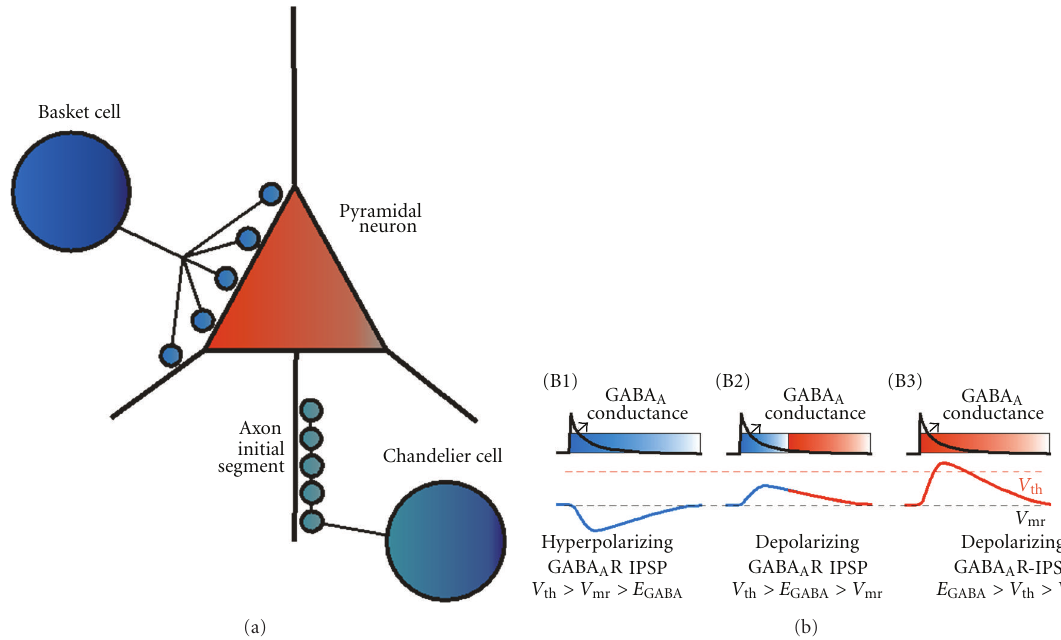
Figure 3: Diversity of perisomatic-targeting GABA neuron-mediated inhibition in cortical circuits may be due to di ff erences in the reversal potential for the GABA A -mediated current. (a) The scheme illustrates targeting by basket cells (either parvalbumin- or cholechystokinin- positive), which contact the soma and the proximal/perisomatic dendritic compartments, and by chandelier or axoaxonic neurons, which contact the axon initial segment. (b) The schemes illustrate di ff erences in the postsynaptic e ff ect of a GABA A R conductance according to the ) relative to the resting membrane potential ( V mr ) and the threshold potential value of the reversal potential for the GABA A current ( E GABA A to fire spikes ( V th ). In (B1) to (B3), the time course of the GABA A R-mediated conductance, chosen to be identical in all panels, is shown by the black traces and the IPSPs are shown by the blue/red traces. Note that the IPSP time course is always slower than the GABA A conductance, although in the scheme the di ff erence in time course is somewhat exaggerated for illustration purposes and does not match the actual time is negative relative to V mr ( V th > V mr > E GABA ), and the GABA A conductance generates a scales. (B1) Illustration of cases in which E GABA A A hyperpolarizing IPSP (all blue IPSP trace). As the IPSP outlasts the GABA A conductance, the duration of the inhibitory e ff ect of the synaptic input (shown by the shaded blue rectangle) is extended by the membrane hyperpolarization that remains after the GABA A conductance > V is positive relative to V mr ( V th > E GABA decays. (B2) Illustration of cases in which the IPSP is depolarizing because E GABA mr ). Just as A A is below V th , and therefore the hyperpolarizing IPSP, the depolarizing IPSP outlasts the GABA A conductance; however, in this case E GABA A the depolarizing IPSP could have a dual inhibitory/excitatory e ff ect (blue/red IPSP trace), initially producing shunting inhibition which lasts approximately the same time as the GABA A conductance (shaded blue/red rectangle), followed by an enhanced excitability of the is positive relative postsynaptic neuron due to the remaining phase of the depolarizing IPSP. (B3) Illustration of cases in which E GABA A > V > V ff ect (shaded red rectangle). Basket cells are to V th ( E GABA th mr ). In this case, the depolarizing IPSP has a purely excitatory e A thought to produce hyperpolarizing GABA A R-mediated inhibition of pyramidal cells such as that illustrated in (B1). In contrast, the e ff ect of chandelier neuron inputs is currently debatable, some studies suggesting an excitatory as that in (B3), other studies suggesting a purely inhibitory e ff ect. Here, we suggest that depolarizing chandelier cell inputs may have a dual inhibitory/excitatory e ff ect, illustrated in (B2), which could synchronize postsynaptic cells as described in Figure 2, although the depolarizing nature of the IPSP may accelerate the timing of synchronous firing after the postsynaptic cells escape from